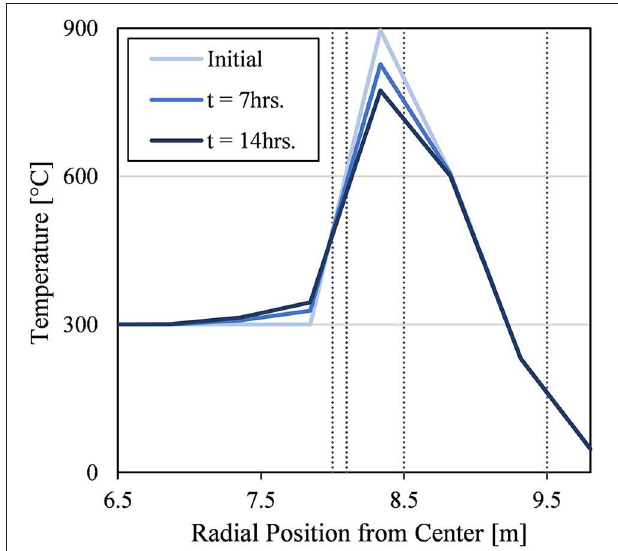
FIGURE 9 | lD temperature profile along the radial direction at the midplane of the silo during the tenth recovery step. The initial condition from the final time step of the prior discharge step. Gray lines mark changes in material (from left to right): Particle, Refractory A, Refractory B, CaSi, and Concrete.